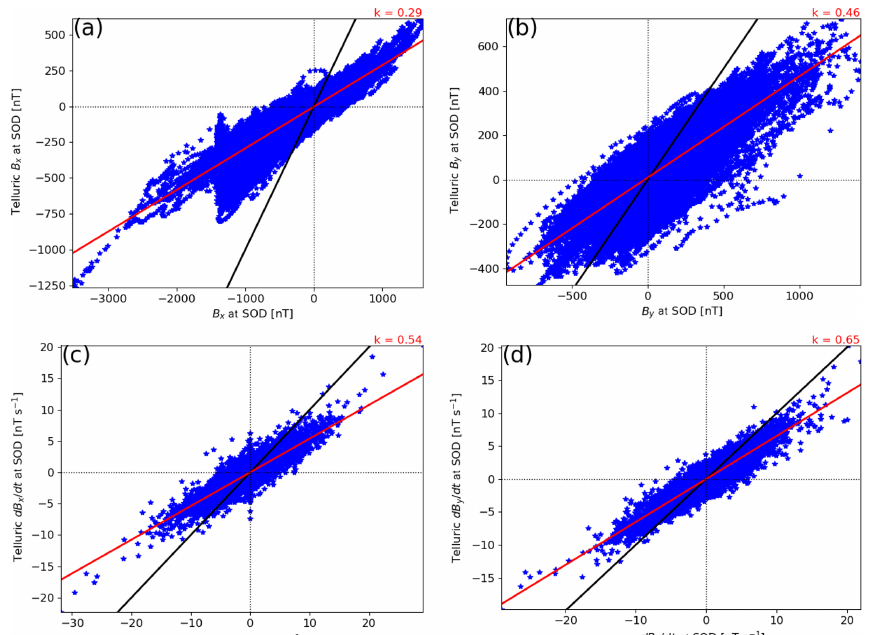
Figure 6. Telluric contribution to B x as a function of measured B x at SOD in 1996–2018 (a) . Only values with large time derivatives of the horizontal magnetic field (d H/ d t > 1nTs − 1 ) are included. The black line is the line of unity, and the red line is a least squares fit to the data points. The slope of this line is indicated at the top right corner of the panel. The same applies to B y (b) , d B x / d t (c) , and d B y / d t